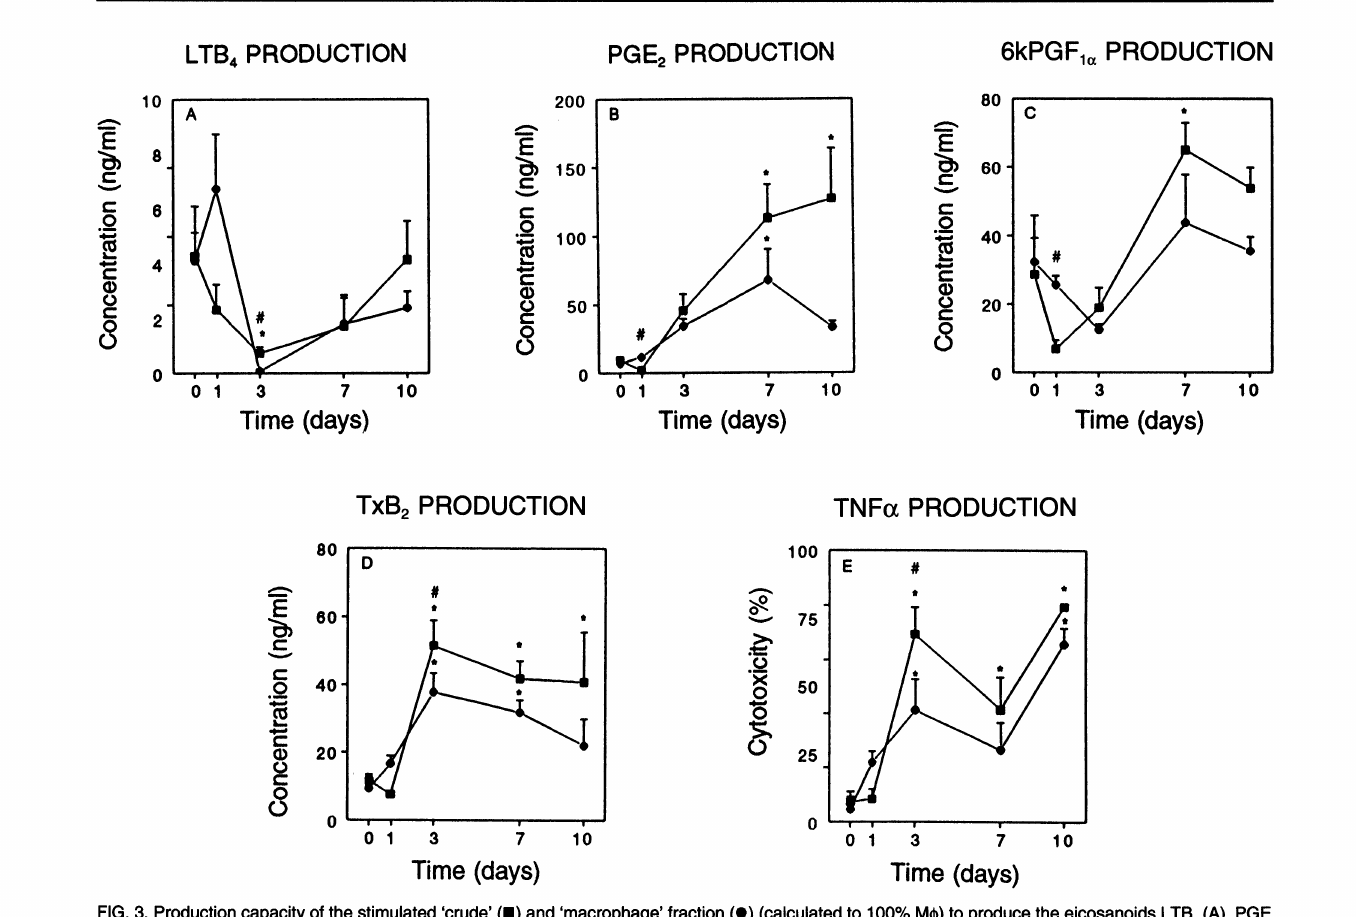
FIG. 3. Production capacity of the stimulated ’crude’ (B) and ’macrophage’ fraction (e) (calculated to 100% M) to produce the eicosanoids LTB (A), PGE (B), 6kPGFI (C), TXB2 (D) and the cytokine TNFo (E). LTB production of 106 cells/ml determined in supernatant after 15 min, IM A23187 stimulation. PGE, TXB, 6kPGFI, TNFo production of 106 cells/ml determined in supernatant after 24 h 10 g/ml LPS stimulation; mean +_ S.E.M.; "p < 0.05 vs. day 0; "p < 0.05 granulocytes vs. macrophages; n 4-6.